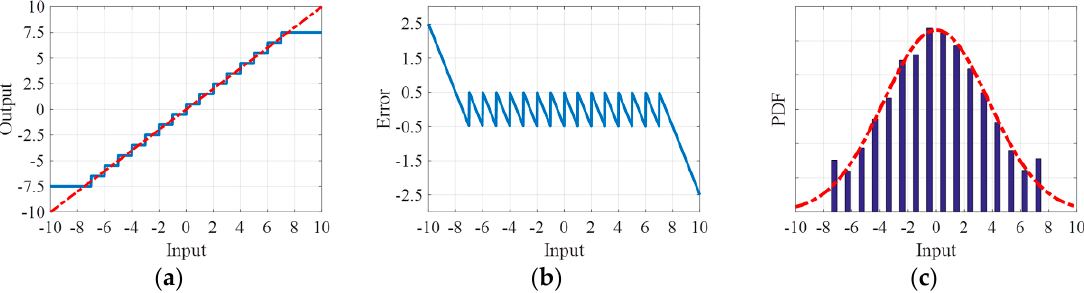
Figure 3. ADC at 4-bits of quantization. ( a ) The dotted line indicates the input analog signal, and the solid line indicates the output digital signal. Values exceeding ±7.5 are set to the threshold, the continuous values are discretized. ( b ) The quantization error from the values within the threshold range is between ±0.5, and the saturation error is always larger than the quantization error. ( c ) The continuous Gaussian probability distribution (dotted line) becomes discrete (histogram).